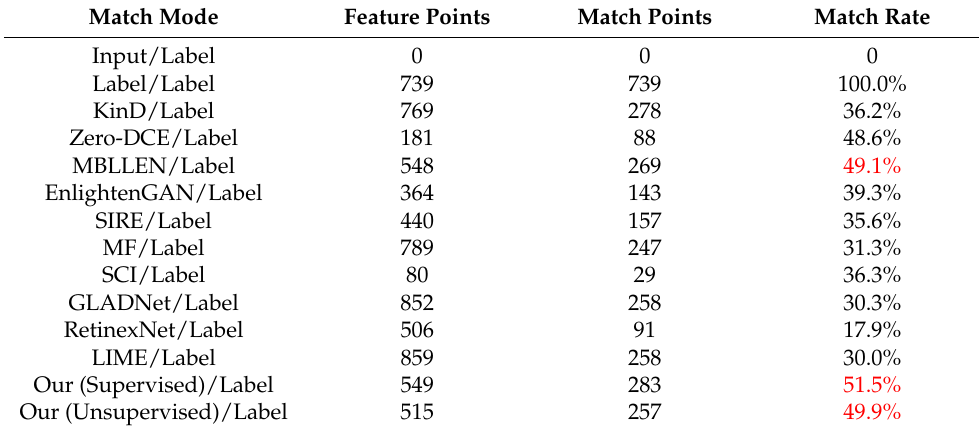
Table 3. Comparison of image matching results enhanced by different algorithms.